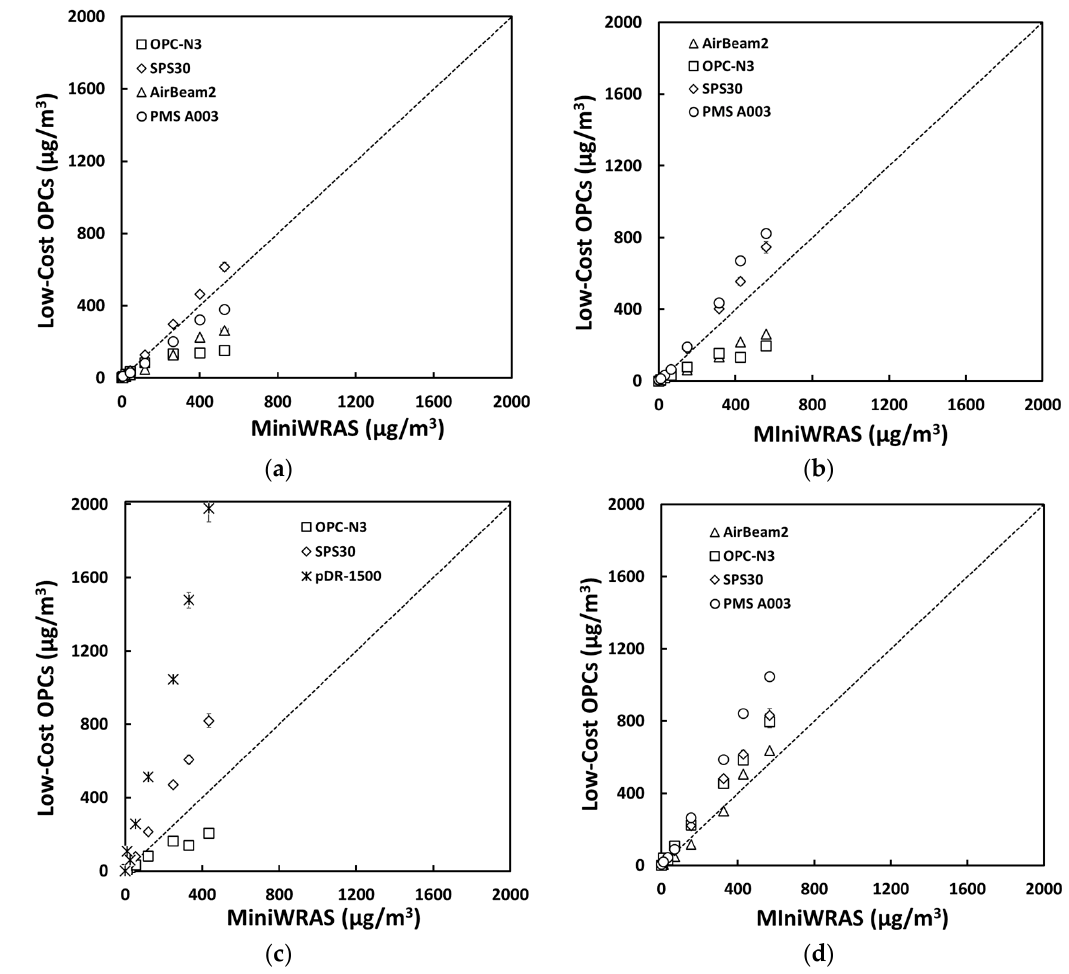
Figure 3. The mass concentrations (µg/m 3 ) of ( a ) PM 1 , ( b ) PM 2.5 , ( c ) PM 4 mc, and ( d ) PM 10 reported by the sensors plotted against the reference device for the salt occupational experiment.